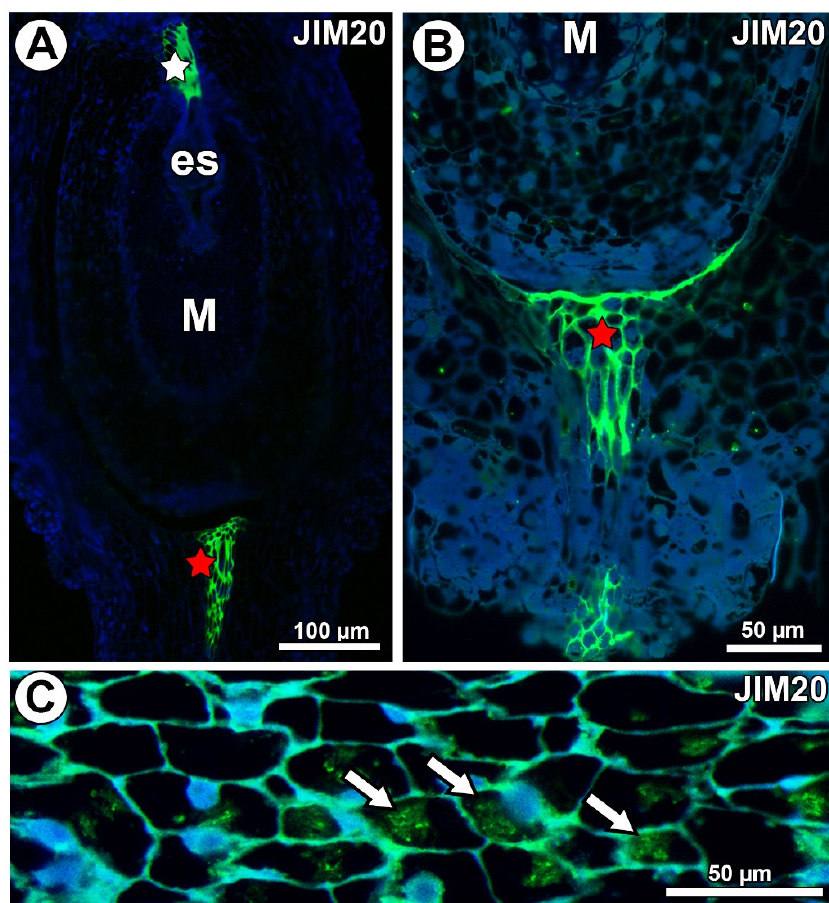
Figure 10. Extensin (labeled with JIM20) detection. ( A ) Section through the ovule of Taraxacum officinale ; note the mucilage cells (M) and occurrence of extensins in the transmitting tissue (white star) and pistil transmitting tissue (red star). ( B ) Occurrence of extensins in pistil transmitting tissue of Pilosella officinarum . ( C ) Association between extensins and calcium oxalate crystals (arrows) in P. officinarum ovule.